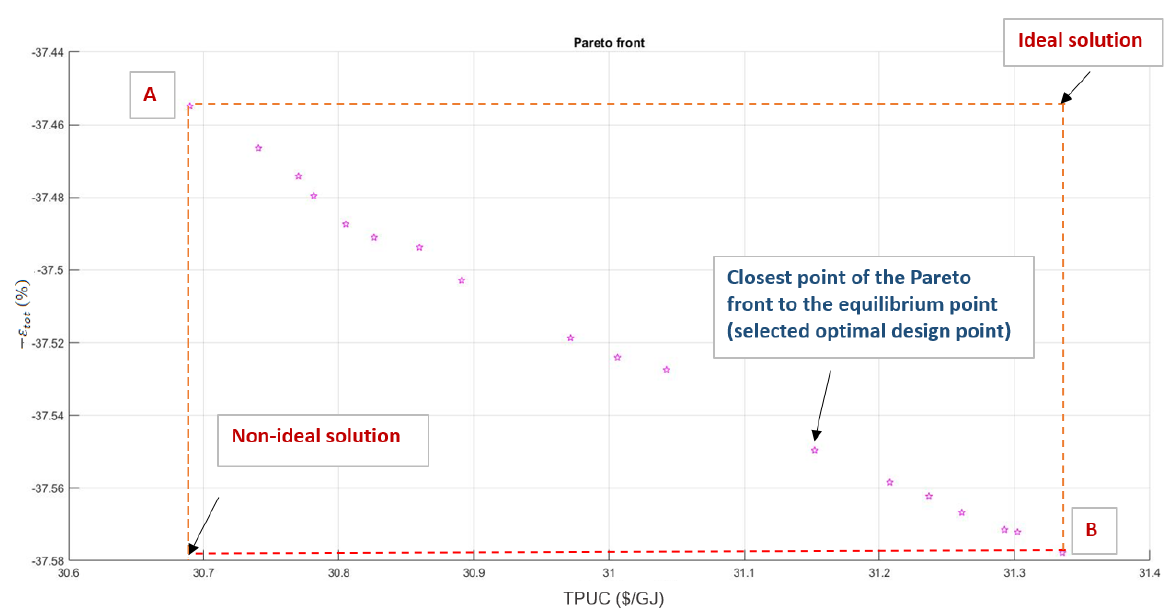
Figure 16. Pareto optimal solutions of the system ’ s TPUC and for exergy efficiency.